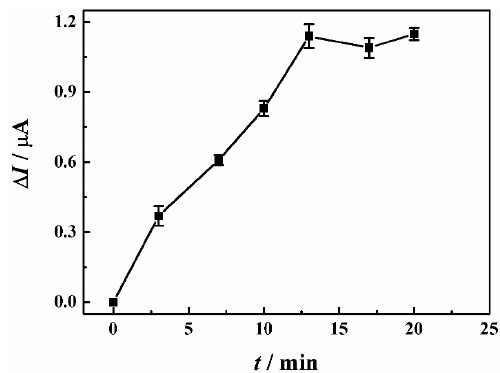
Figure 7. Influence of the incubation time on the current response of the imprinted sensor towards AFP at the concentration of 1.0 ng mL − 1 .